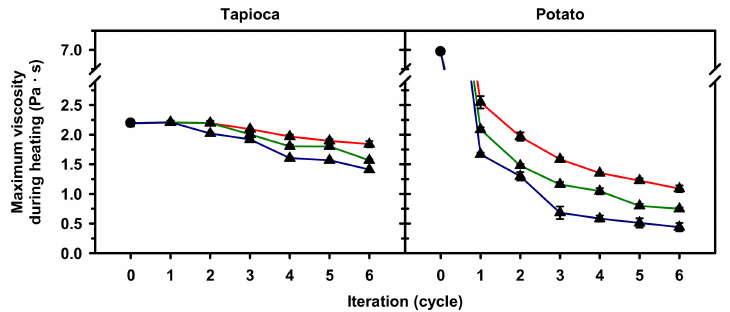
Figure 6. Maximum viscosity during heating of native ( • ) and heat–moisture treated ( (cid:78) ) starches with 0 ( — ), 30 ( — ) or 60 ( — ) min holding time and 1–6 iterations. Analyses were performed in